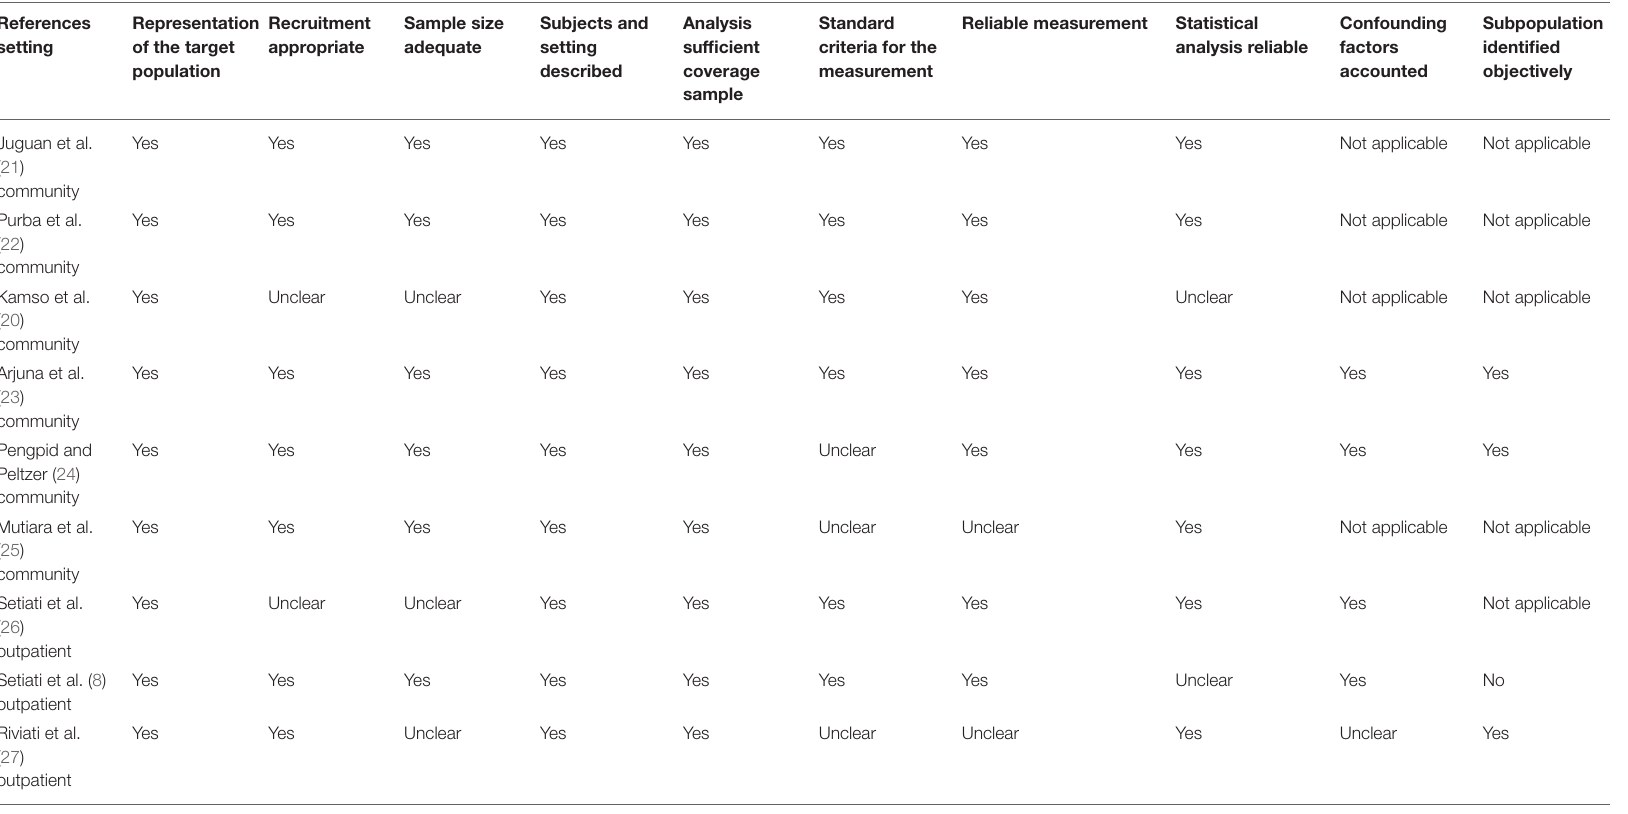
TABLE 2 | Risk of bias assessed by the Joanna Brigg’s Institute (JBI) critical appraisal checklist for studies reporting prevalence of malnutrition data. References